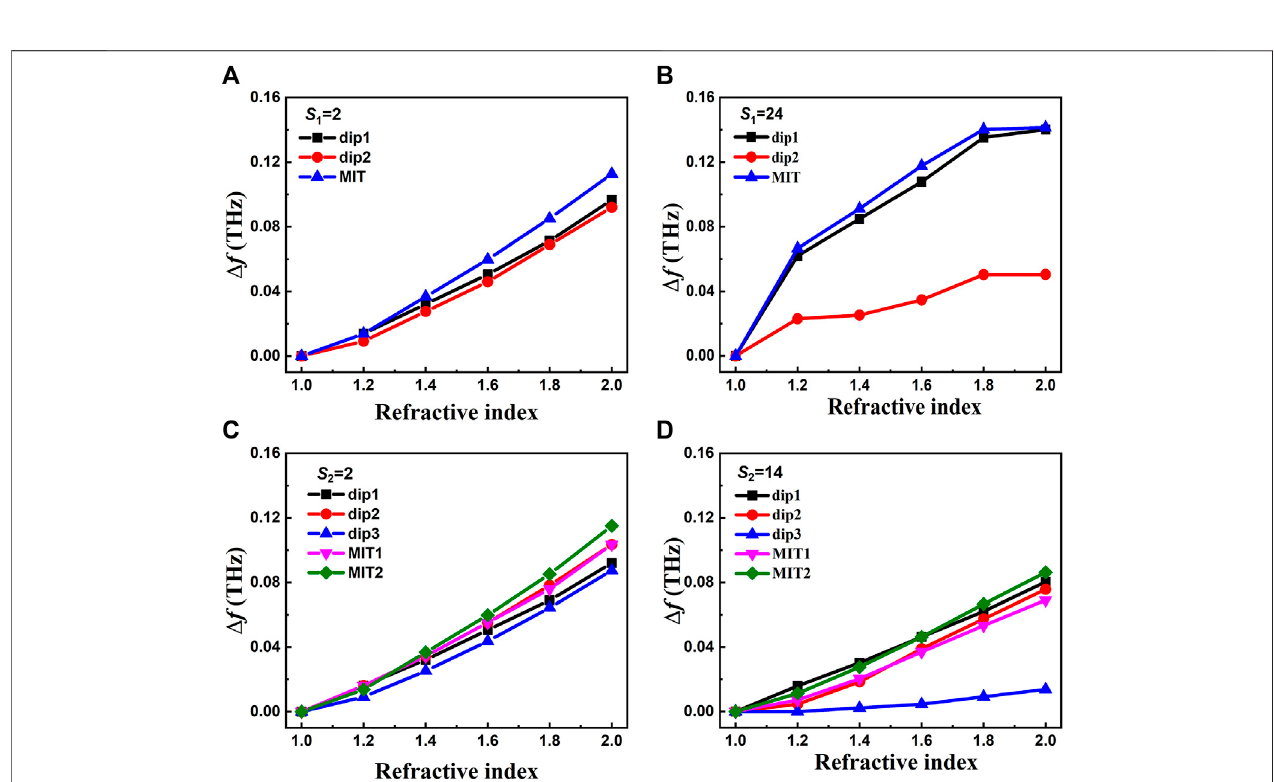
FIGURE9| Simulatedfrequencyshiftwiththechangeoftherefractiveindexofthe100 μ moverlayeranalyteformetastructuresM12with S 1 of2 (A) and24 μ m (B) , and M123 with S 2 of 2 (C) and 14 μ m (D) .